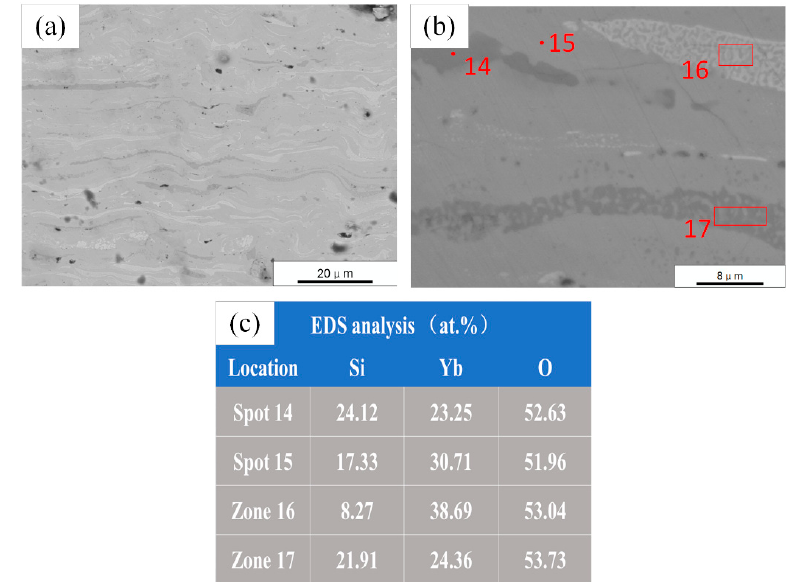
Figure 10. SEM micrographs of annealed ytterbium silicate top-coats prepared by parameter set B: ( a,b ) Cross section by back-scattered electron; and ( c ) EDS analysis of four spots in ( b ).